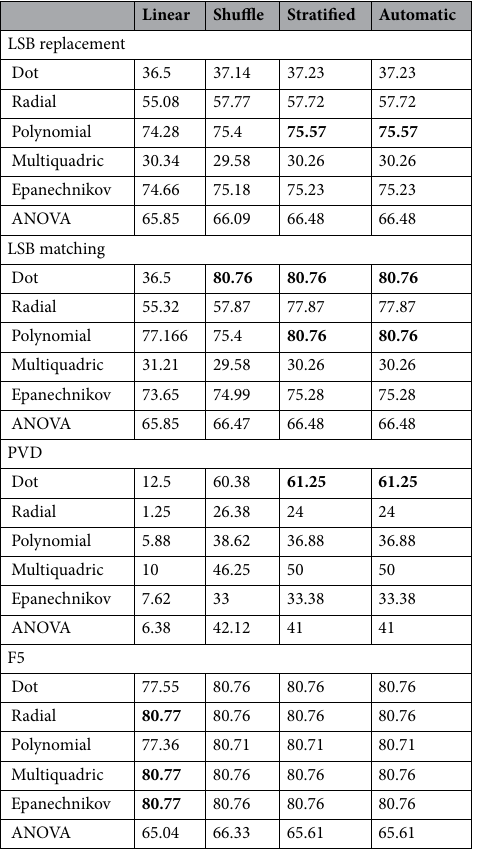
Table 10. Classification of calibrated images with cross-validation using SVM-PSO for random %. Significant values are in bold.